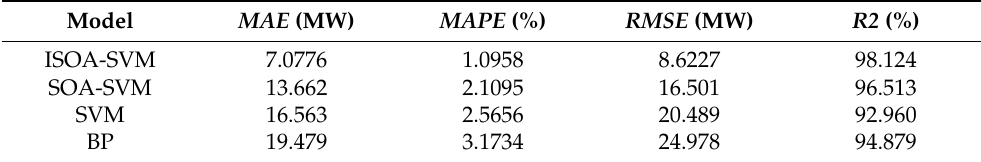
Table 5. Evaluation table of power load forecasting results of Case 1.